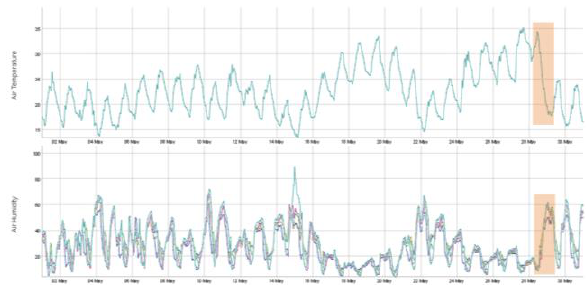
Figure 6. Air temperature (upper diagram) and humidity (lower diagram) trends measured in May 2015. The orange area corresponds to the time of the rock